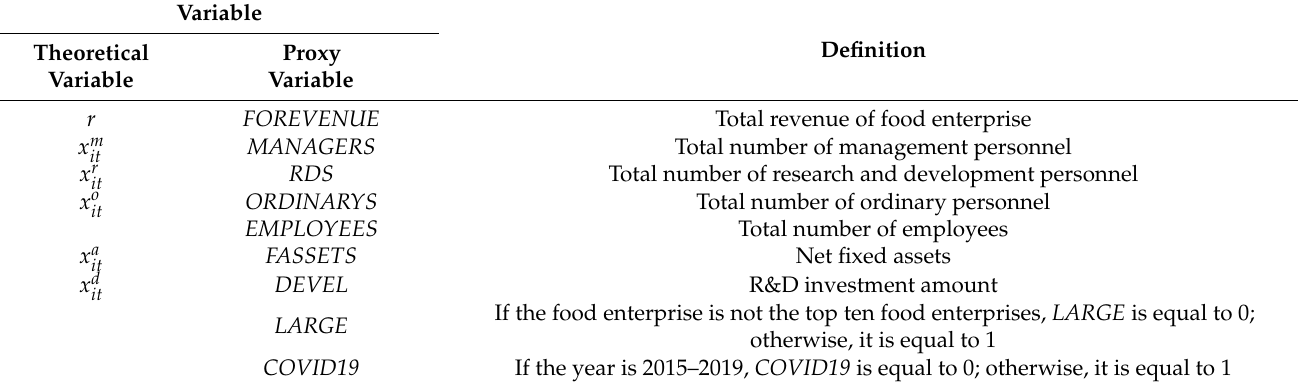
Table 1. Variable